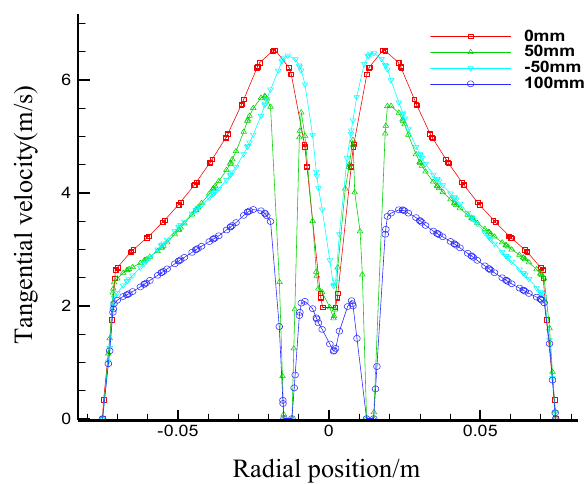
Figure 15. Tangential velocity inside cyclone with different insertion depth of inner vortex finder.